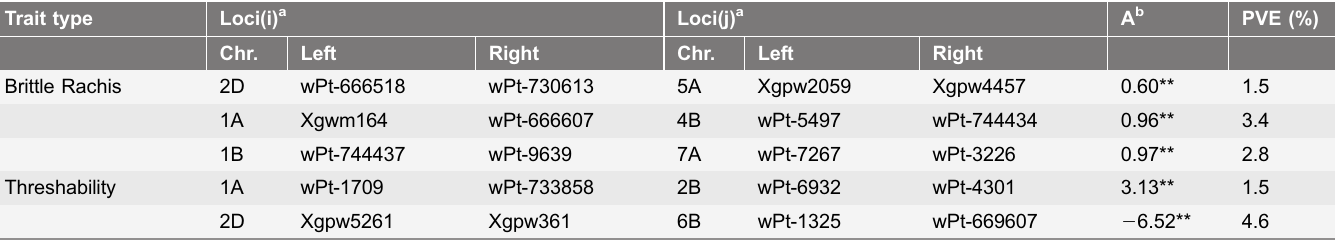
Table 4. Epistases for brittle rachis and threshability in the Triticum aestivum ssp. tibetanum Shao population from accessions Q1028 6 ZM9023. Trait